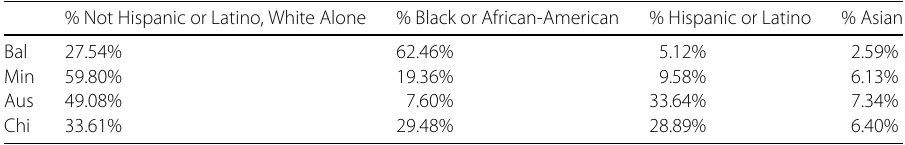
Table 1 The percentage of population across race and ethnicity for the four cities according to the American Community Survey (2019 ACS 5-year estimates) [42]. The cities are: Baltimore (Bal), Minneapolis (Min), Austin (Aus) and Chicago (Chi) % Not Hispanic or Latino, White Alone % Black or African-American % Hispanic or Latino % Asian Bal 27.54% 62.46%